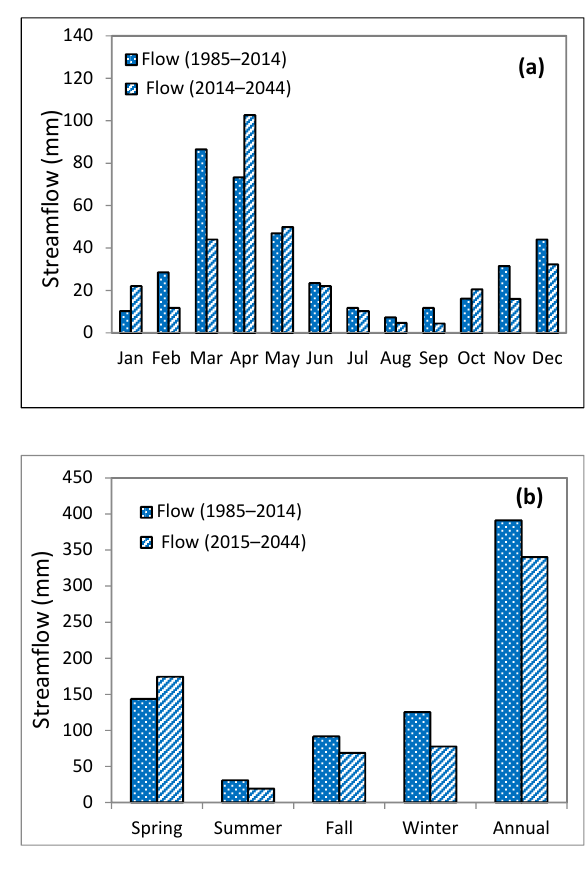
Table 4. Water Balance Components for Historical (1985–2014) and Future (2015–2044) Periods.